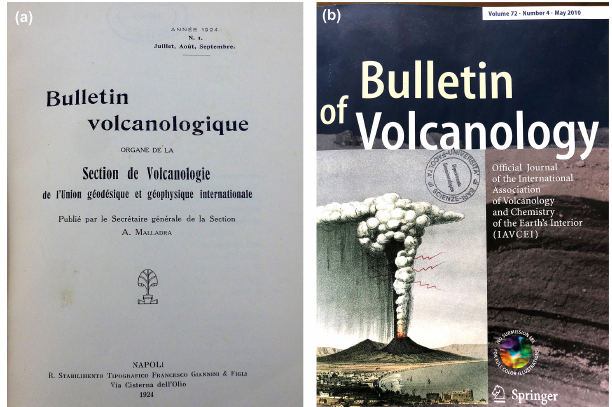
Figure 2. Two versions of the cover of BV . (a) Volume 1, no. 1, from July–September 1924. (b) Cover design from last hard-copy version of BV , this issue being Volume 72, no. 4,